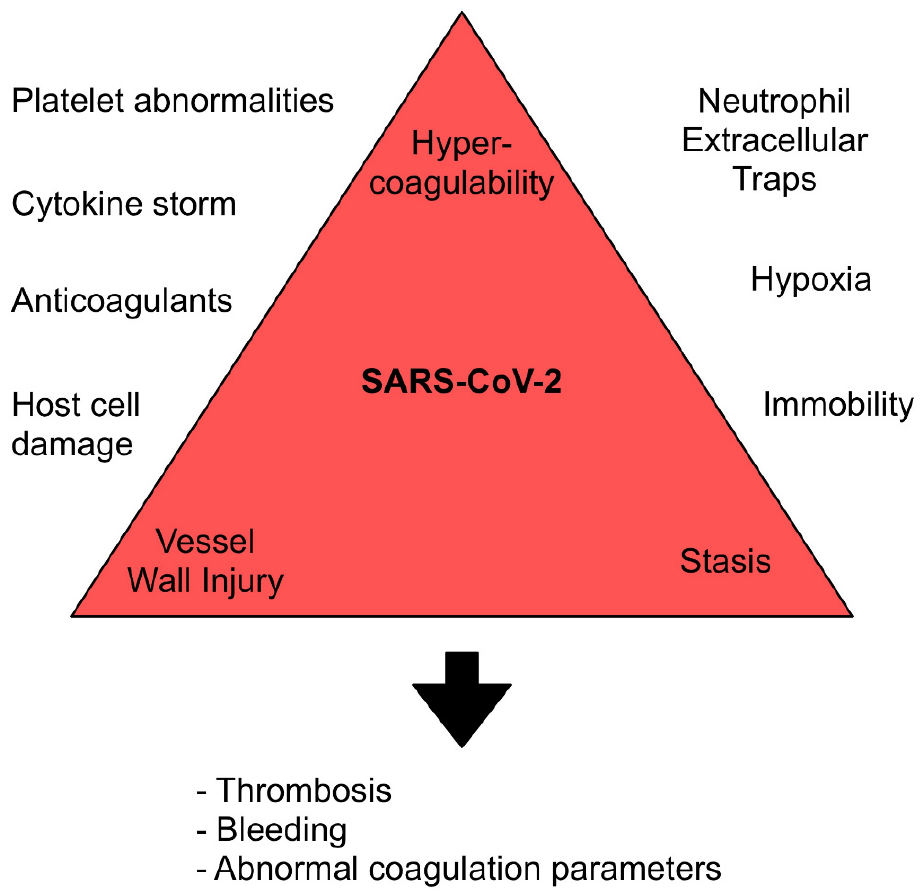
Figure 1. Mechanisms of coagulation abnormalities in COVID-19 patients.